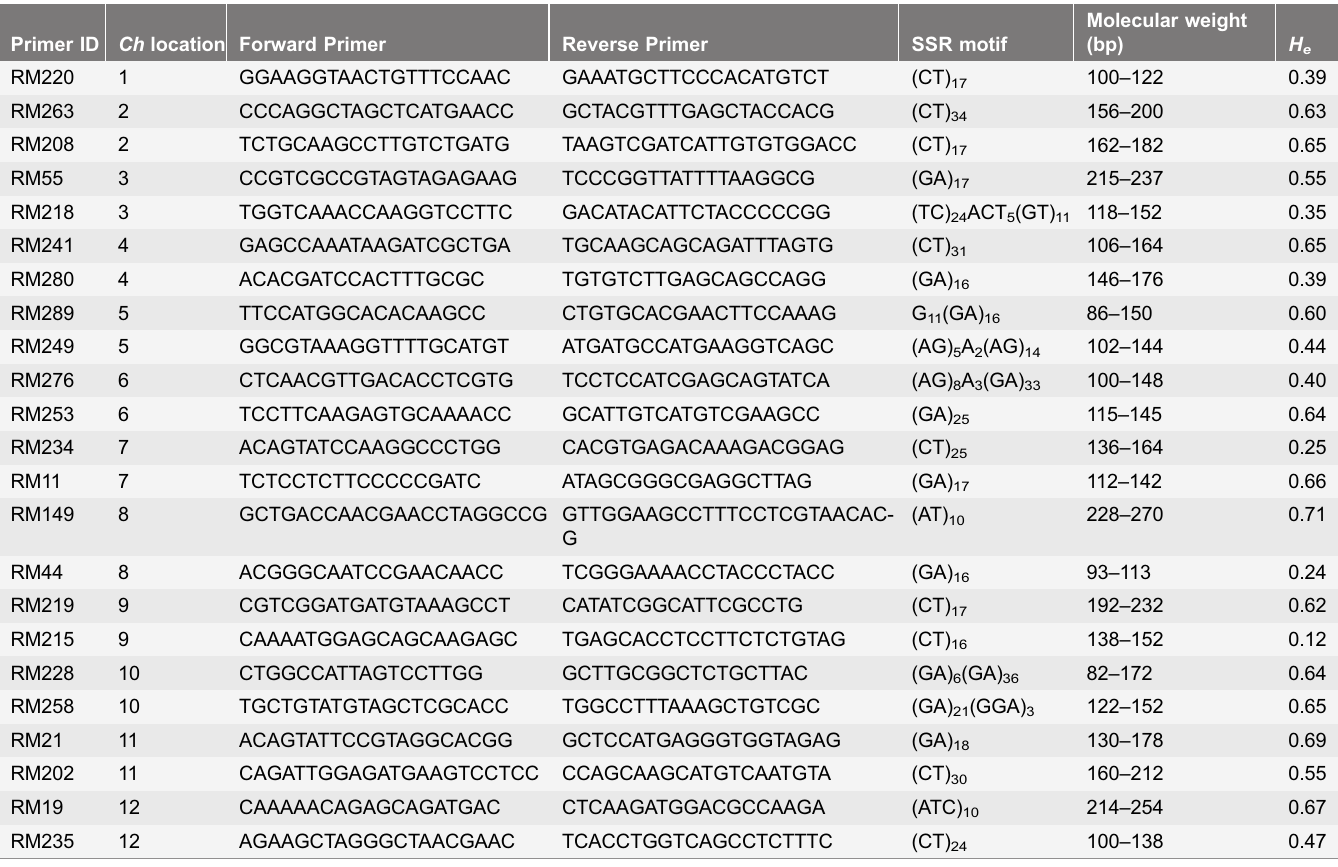
Table 2. The 23 SSR primer pairs used in this study with detail information on their DNA sequences, motifs, molecular weight, and expected heterozygosity in the examined weedy rice materials. Primer ID Ch location Forward